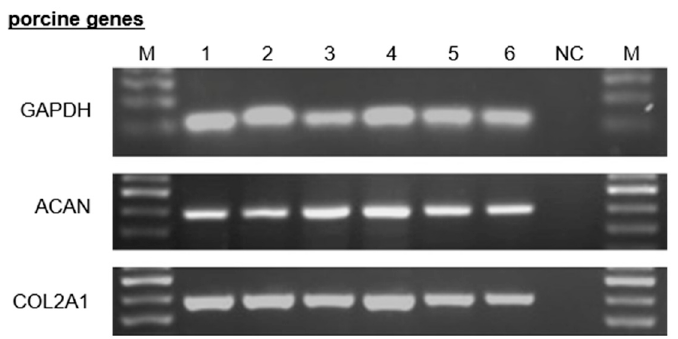
Figure 1. Expression of porcine ECM related genes. Representative RT-PCR of WT and genetically modified porcine chondrocytes regarding porcine COL2A1 and ACAN, whereas porcine GAPDH served as control. The corresponding samples were loaded for electrophoresis in the following order: lane M: bp marker; lane 1: WT; lane 2: TG; lane 3: GalTKO; lane 4: GalTKO/TG; lane 5: GalT/CMAHKO; lane 6: GalT/CMAHKO/TG; NC: negative control.